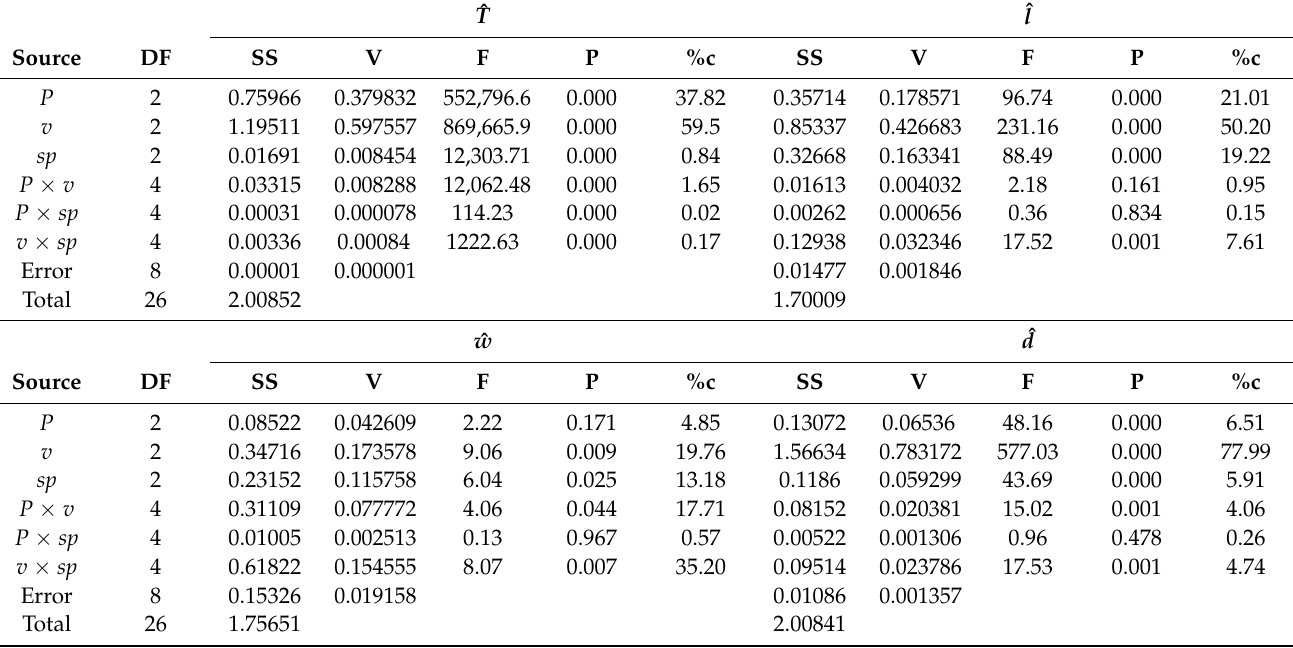
Table 6. The ANOVA table for ˆ T , ˆ l , ˆ w , and ˆ d